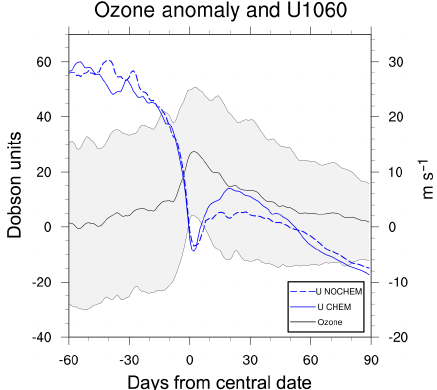
Figure 6. Eddy heat flux (in mKs − 1 ) over 40–80 ◦ N from − 60 to + 30d around the DJF SSW central dates. The CHEM average is in blue with confidence intervals shown in pale blue. The NOCHEM average is in black with confidence intervals shown in gray.